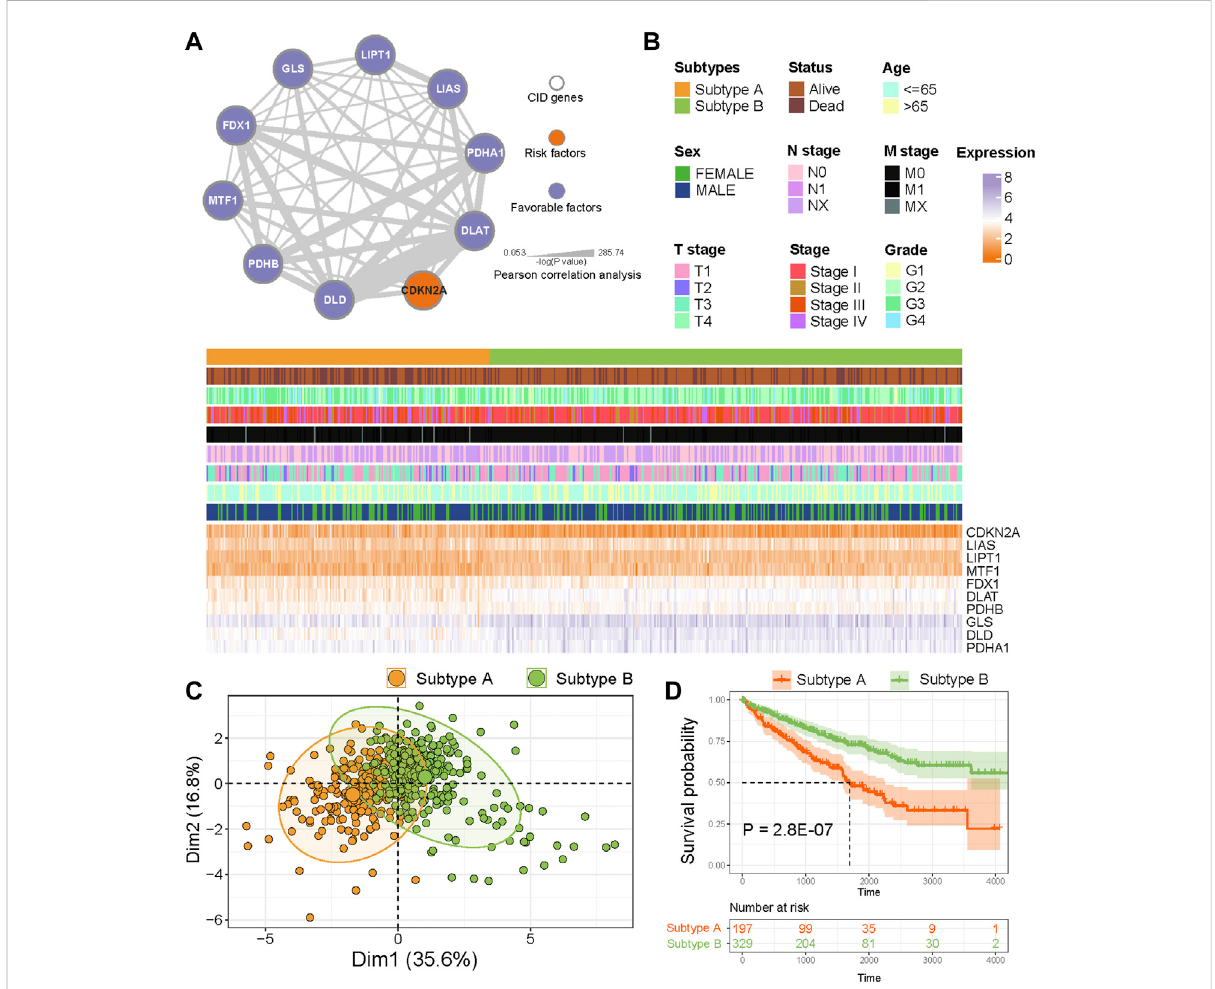
B (Figure 4A, |log2FC| > 1, FDR < 0.001). Pathway and